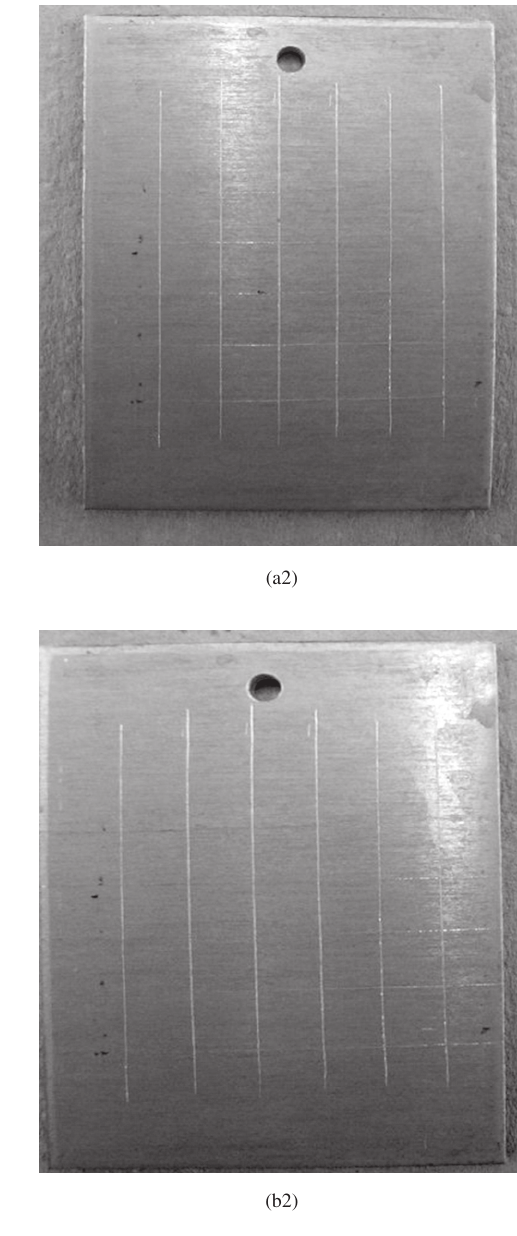
Figure 8. Sequence of the adhesion test on surface AA 2024-T3, with Ce-conversion layer (a1, b1) and bi-layer Ce-silane (a2, b2). Images obtained with digital